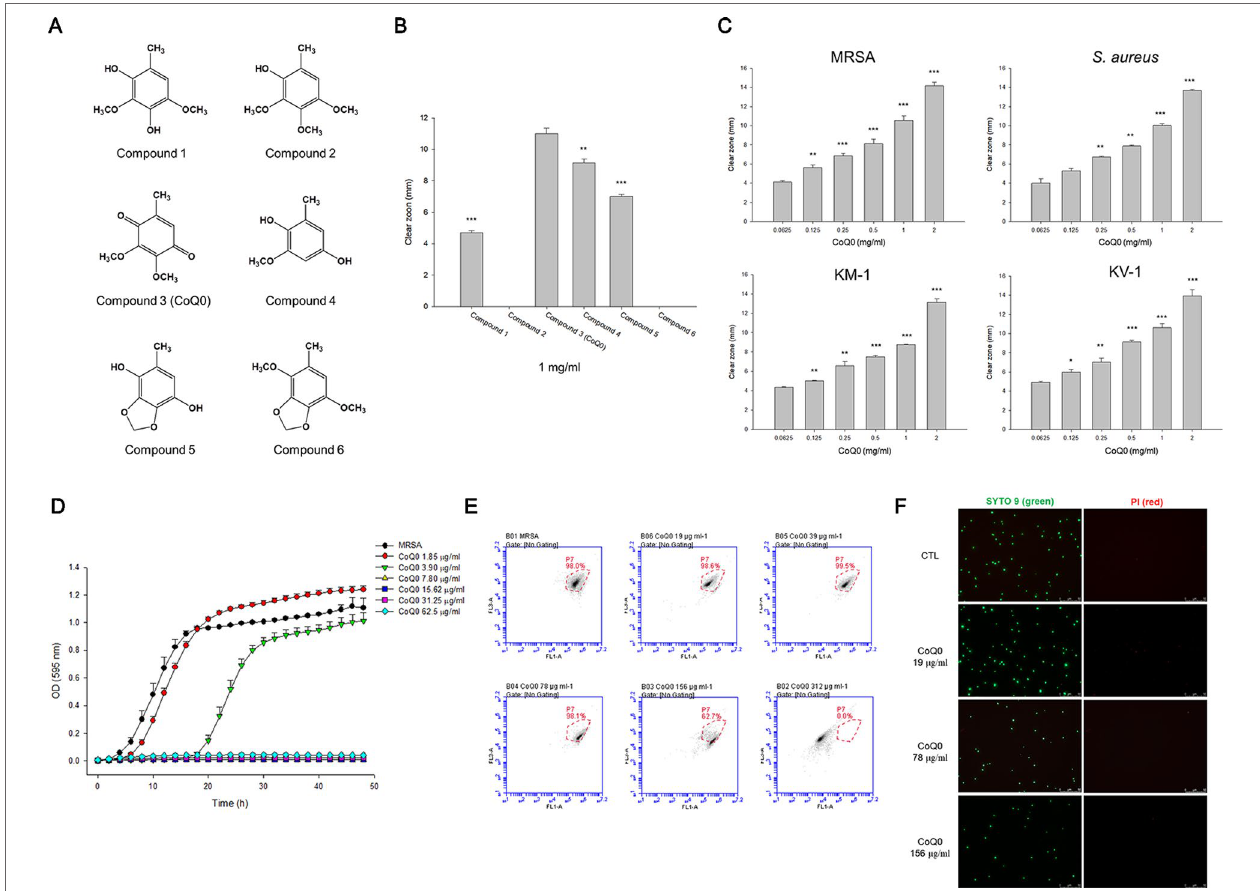
FIgURE 1 | Determination of the antibacterial activity of A. cinnamomea extracted benzenoids. (A) The chemical structures of the benzenoids. (B) Zone of inhibition of MRSA treated by benzenoids measured from agar diffusion assay. (C) Zone of inhibition of MRSA, S. aureus , and VISA treated by CoQ 0 measured from agar diffusion assay. (D) The growth curves of MRSA treated by CoQ 0 at different concentrations within 48 h. (E) The planktonic live/dead MRSA strain determined by flow cytometry. (F) The planktonic live/dead MRSA strain viewed under fluorescence microscopy. Each value represents the mean ± SEM (n = 4). *** p < 0.001; ** p < 0.01; * p < 0.05.